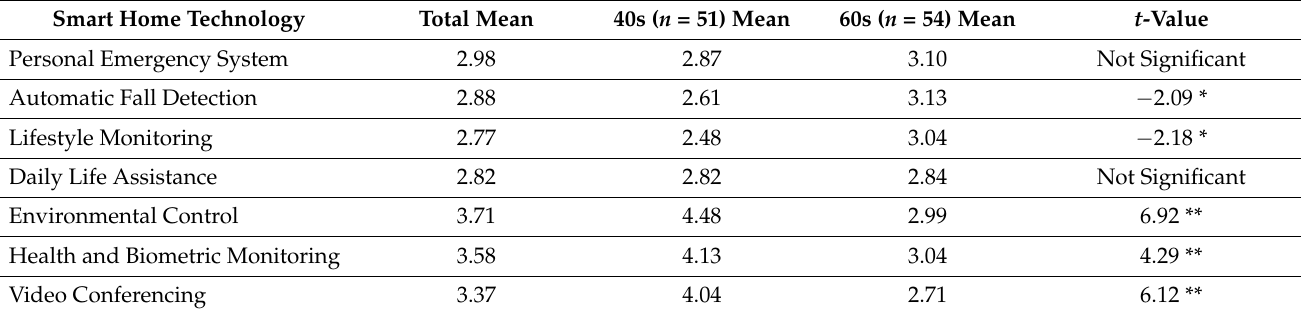
Table 5. Smart Home Technology Preference by Age Group (* p < 0.05, ** p < 0.01).